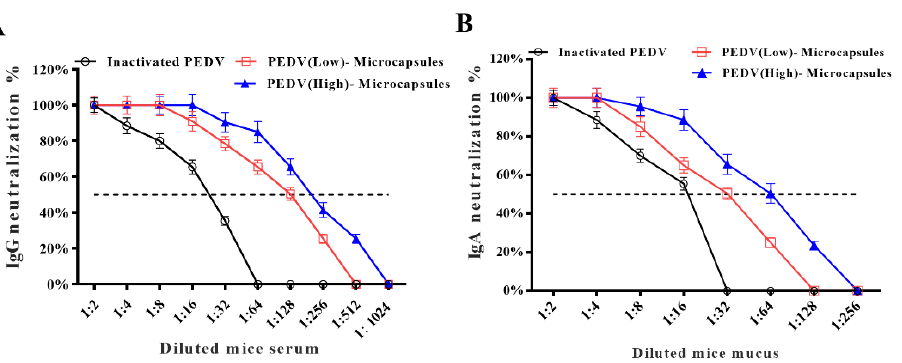
Figure 3. The results of antibody neutralization activity of IgG ( A ) and IgA ( B ). Both neutralization percentages of IgA and IgG in the intestinal mucosa and serum.